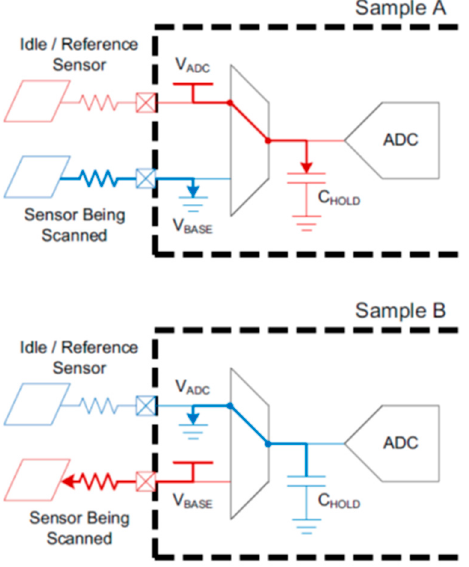
Figure A1. Precharge state: theory of operation [30].